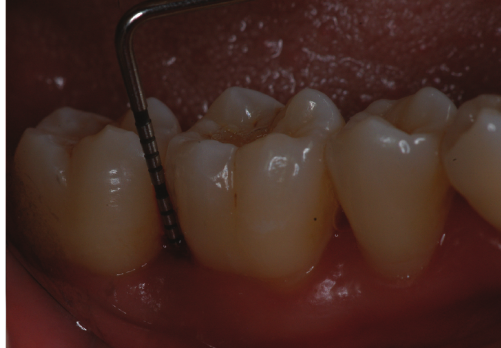
Figure 5: Pathological probing depths were recorded at baseline.